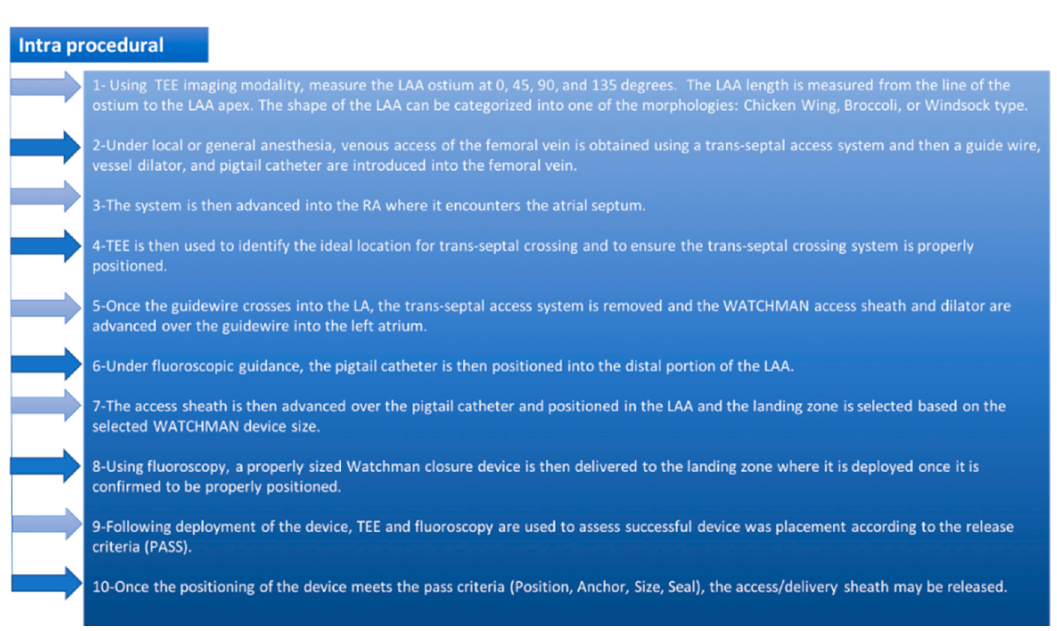
Figure 1. A stepwise approach for pre-, peri-, and post-procedure for the successful implantation of WATCHMAN device.